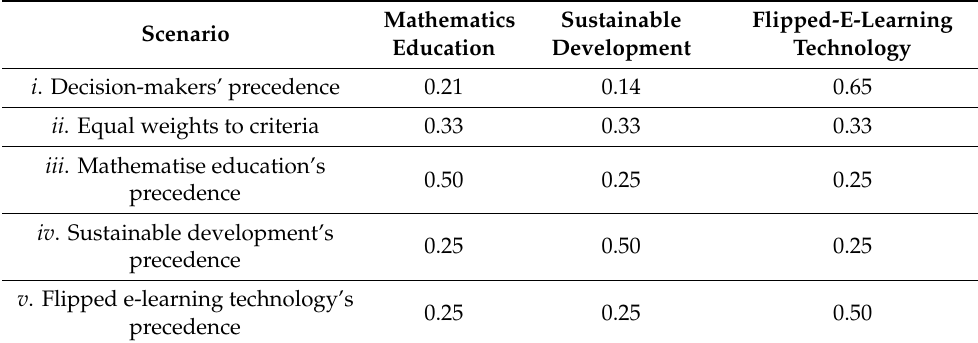
Table 6. Sensitivity analysis application for criteria weights’